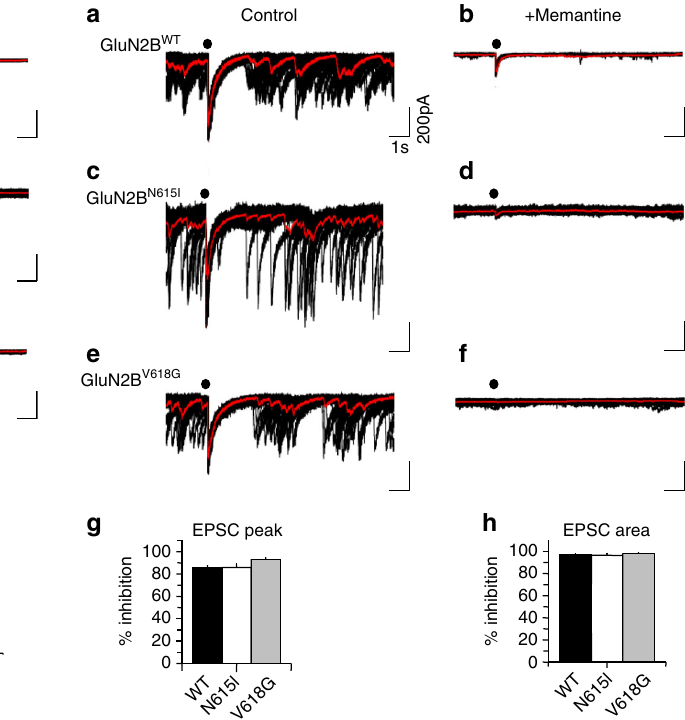
Fig. 7 Ion channel mutants and Mg 2+ block of NMDAR-mediated EPSCs. Hippocampal neurons (13 – 15 DIV) expressing GluN2B WT ( a , b ), GluN2B N615I ( c , d ) or GluN2B V618G ( e , f ) subunits were recorded at − 70 mV in Krebs with either 0 Mg 2+ (Control, a , c , e ) or + 1.2 mM Mg 2+ ( b , d , f ). Bar graphs showing inhibition as a percentage of the mean peak EPSC amplitude ( g ), and charge transfer (area under the evoked EPSCs; ( h ) compared to controls in 0 Mg 2+ for neurons expressing GluN2B WT ,